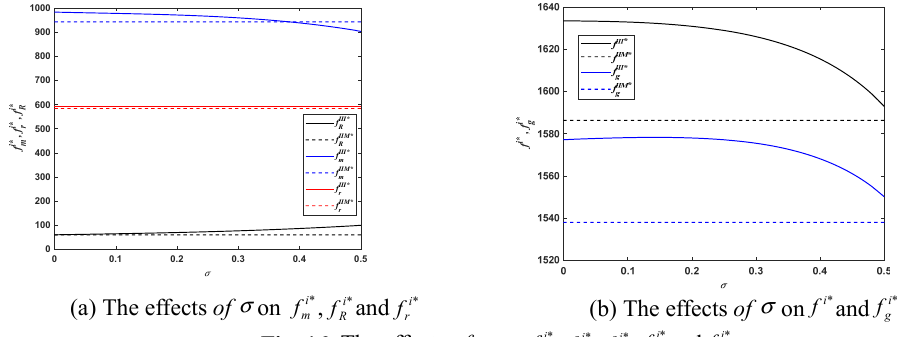
Fig. 16. The effects of σ